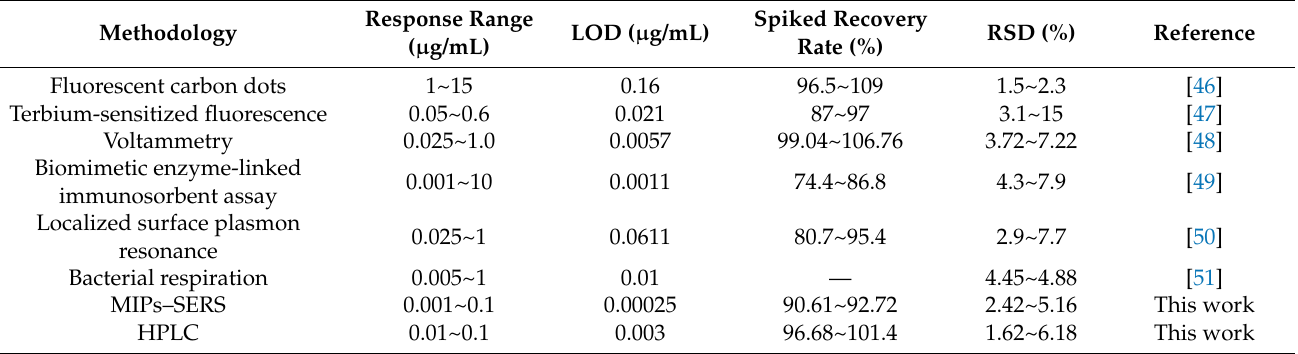
Table 1. Comparison of various methods for the detection of residual